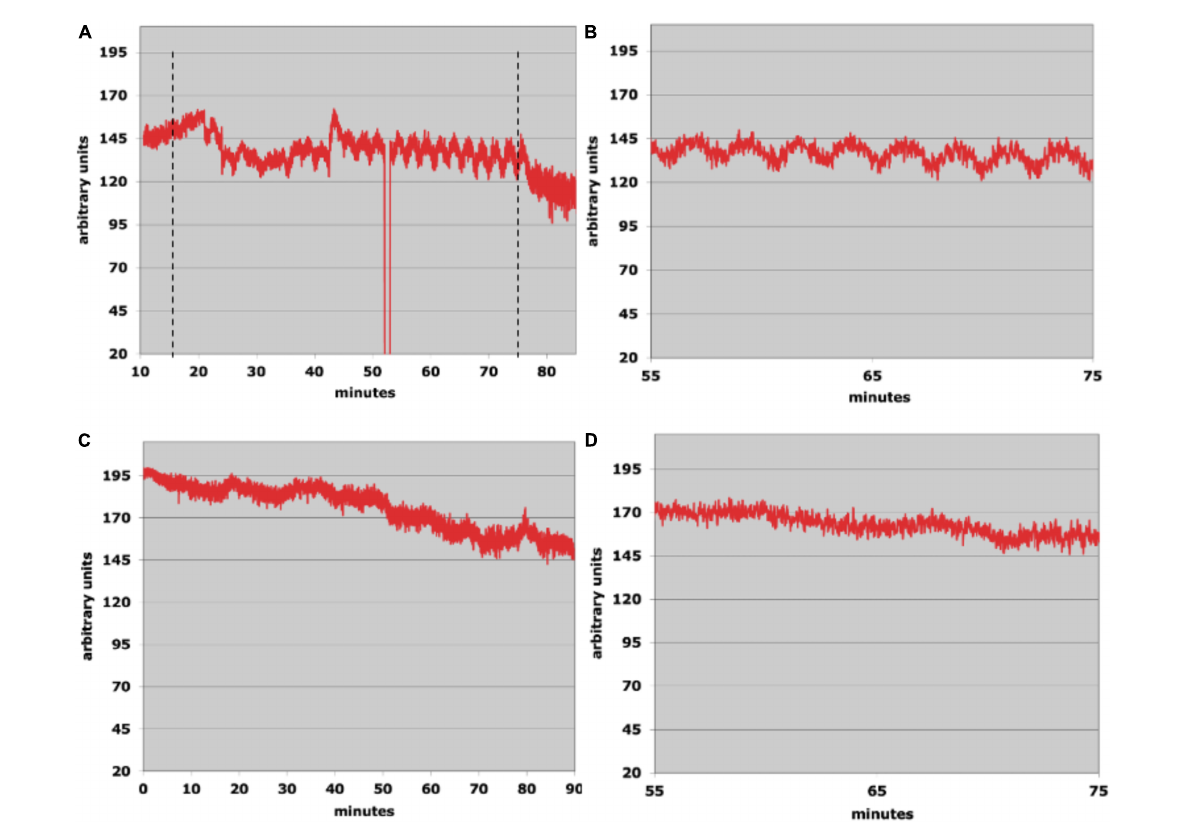
FIGURE3 (A) Laser Doppler flowmetry data; the dotted lines show the start and stop times of the time-varying caloric vestibular stimulation (tvCVS) stimulation (the glitch at ∼ 53 min was due to the recording system falling out briefly and did not affect the measurement otherwise). (B) An expanded view of the oscillations from panel (A) . (C) A control run (no tvCVS stimulation). (D) An expanded view of a segment of the control run.